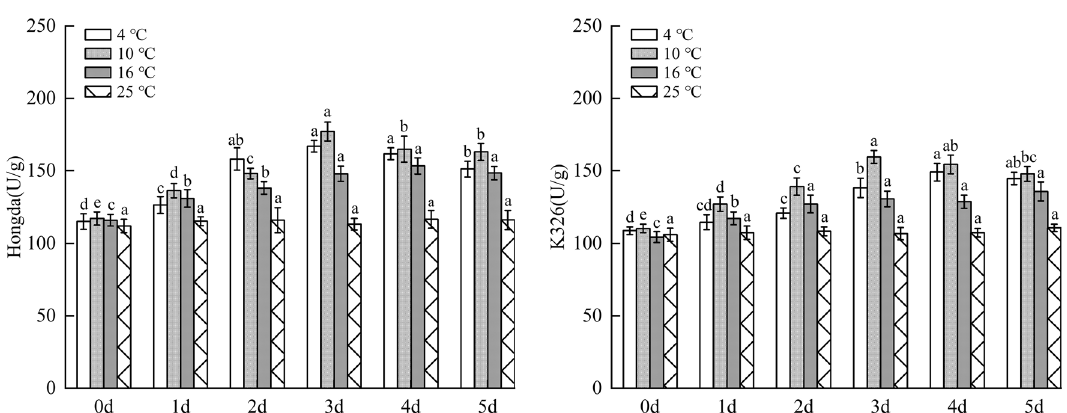
Figure 13. The changes of PPO activity in tobacco leaves under different low-temperature stresses. Different lowercase letters indicated that there were significant differences at different times under the same temperature treatment (P < 0.05).The values were the mean of three biological